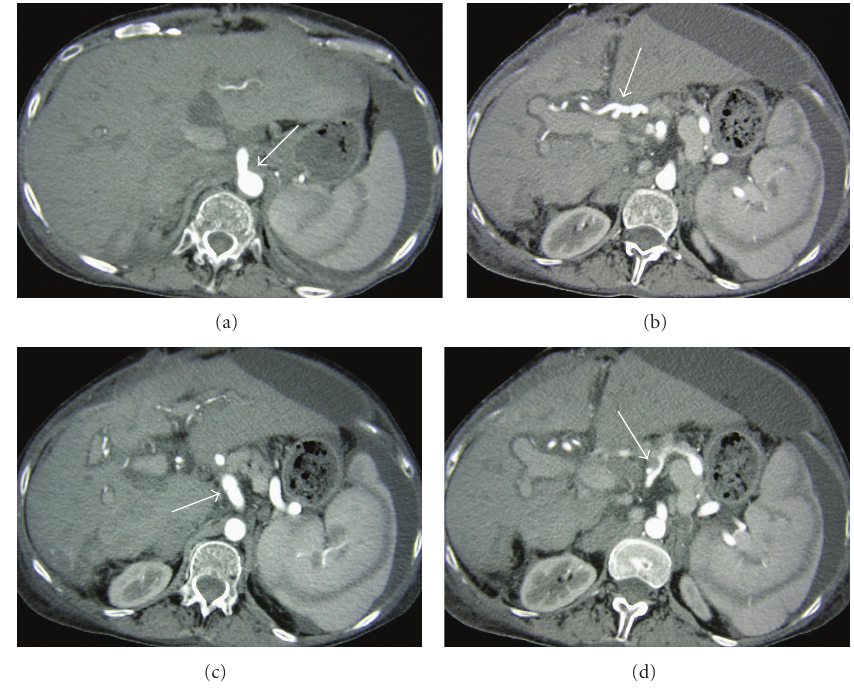
Figure 1: (a) Axial source image from CT angiogram (CTA) demonstrates donor hepatic artery anastomosed to the proximal aorta (arrow). Note normal arterial perfusional striations in the spleen. (b) Axial CTA source image shows the donor hepatic artery coursing to the hepatic hilum (arrow). (c) Axial CTA source image shows thin, transversely oriented intimal flap from an arterial dissection in the recipient celiac trunk (arrow). (d) Axial CTA source image depicts the initmal flap of the celiac trunk dissection extending into the splenic artery. False lumen thrombus in the partially occluded splenic artery is apparent